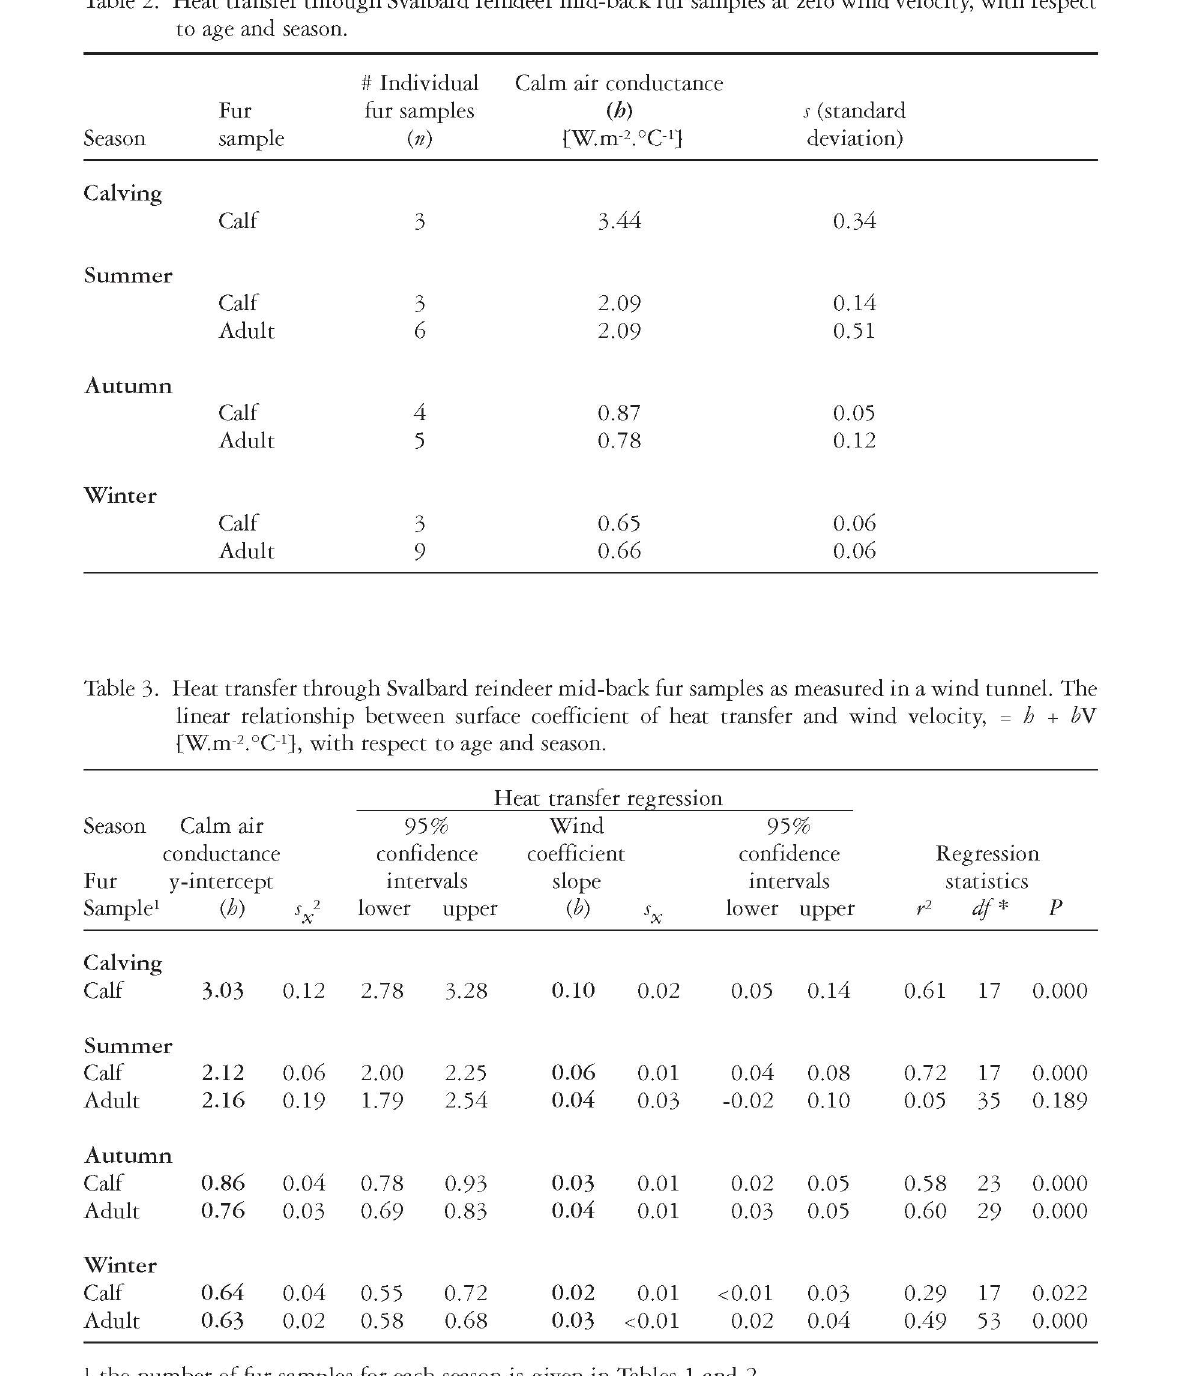
Table 2. Heat transfer through Svalbard reindeer mid-back fur samples at zero wind velocity, with respect to age and season.